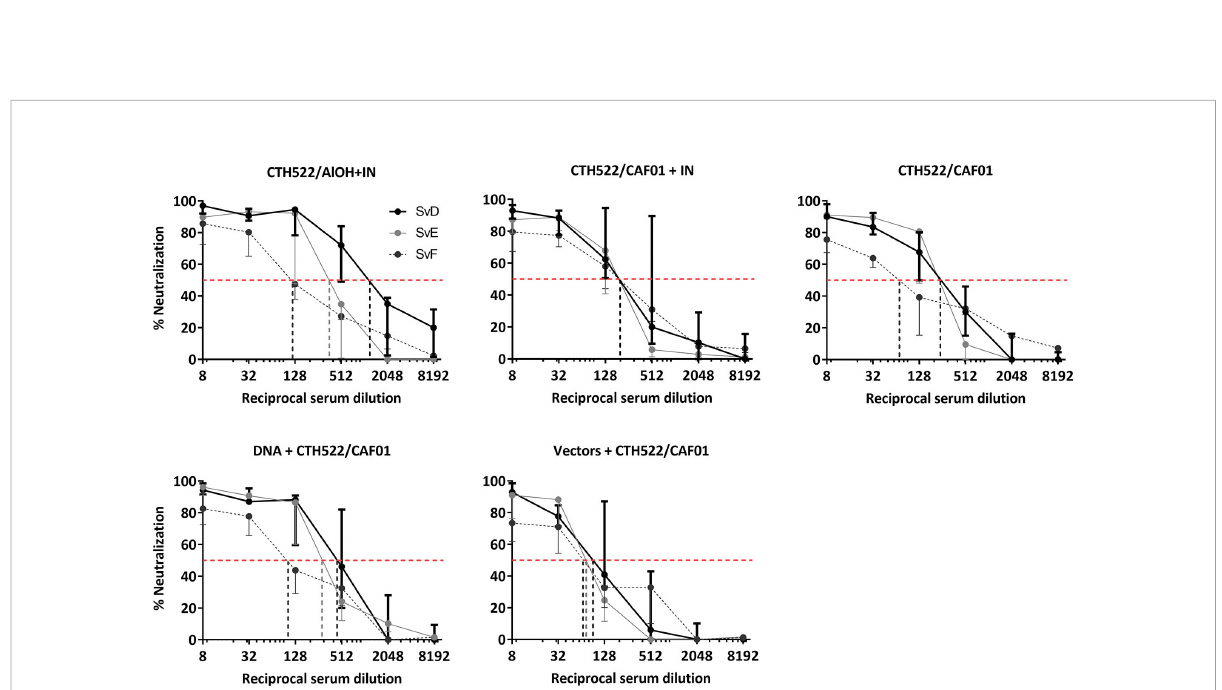
FIGURE 4 In Vitro serum neutralization of C. trachomatis SvD, SvE and SvF. Cynomolgus macaques were immunized following different prime-boost regimes ( n = 5 per group) and serum was collected after fi nishing the immunization schedule (week 24). C. trachomatis SvD, SvE and SvF was incubated with serum from each animal and the capacity of the serum antibodies to inhibit infection were evaluated by incubating the antibody-bacteria mixture on to HaK cells and staining for inclusions. The black line shows SvD, the grey line shows SvE and the dark grey dotted line shows SvF. The dotted red line indicates the reciprocal 50% neutralization titer for each serovar.